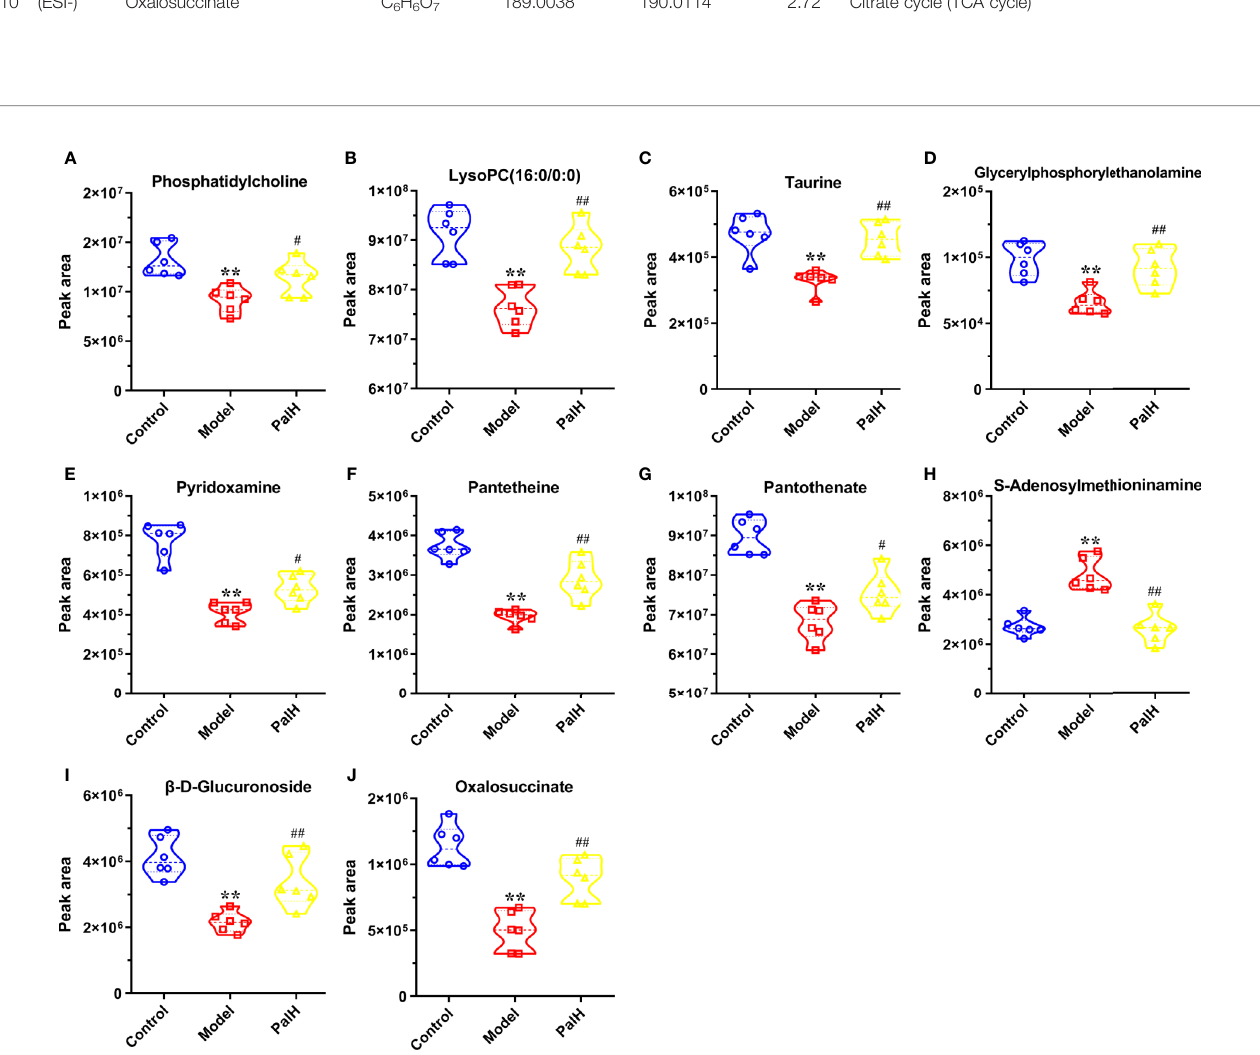
FIGURE 8 | Potential metabolites changes in H. pylori - induced CAG with PalH treatment. (A) Phosphatidylcholine. (B) LysoPC(16:0/0:0). (C) Taurine. (D) Glycerylphosphorylethanolamine. (E) Pyridoxamine. (F) Pantetheine. (G) Pantothenate. (H) S-Adenosylmethioninamine. (I) b -D-Glucuronoside. (J) Oxalosuccinate. ** P < 0.01 vs control group. # P < 0.05 and ## P < 0.01 vs model group. PalH: (40mg /